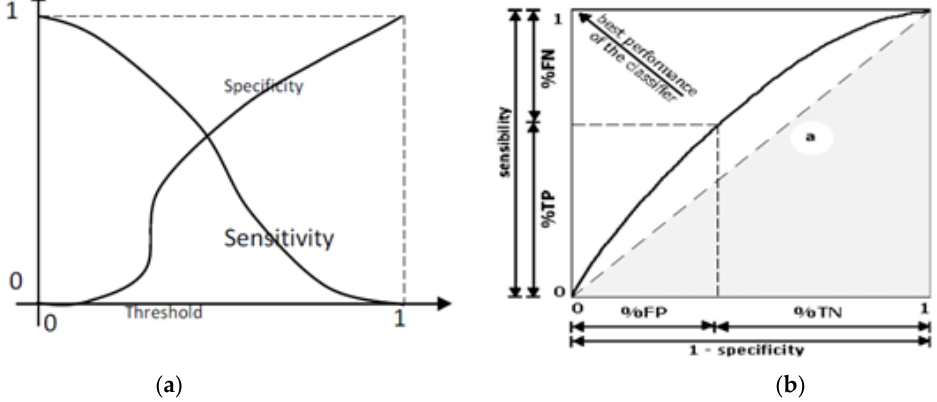
Figure 12. ( a ) Graphs of sensibility versus threshold, specificity versus threshold and ( b ) ROC curve with a hypothetical example [114,115].